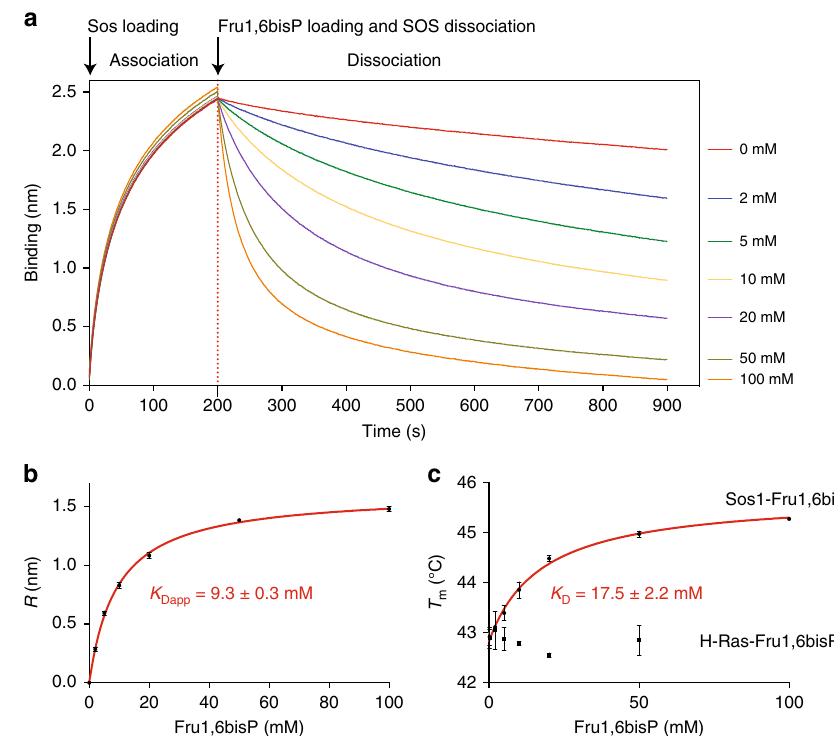
Fig. 7 Fru1,6bisP binds to Sos1 and disrupts the Sos1/H-Ras complex. a , Biolayer interferometry (BLI) measurements showing the disruption of the Sos1/H-Ras complex. His-tagged H-Ras was coupled to Ni 2+ -coated biosensors and loaded with 0.5 µ M of non-tagged Sos1 (association